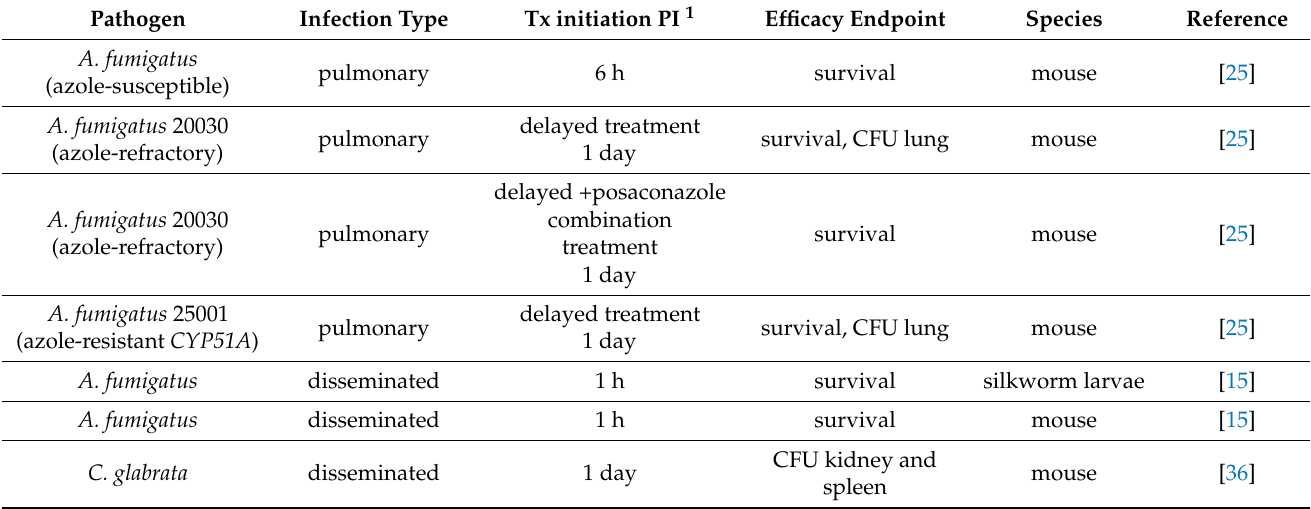
Table 3. Summary of animal models demonstrating GR-2397